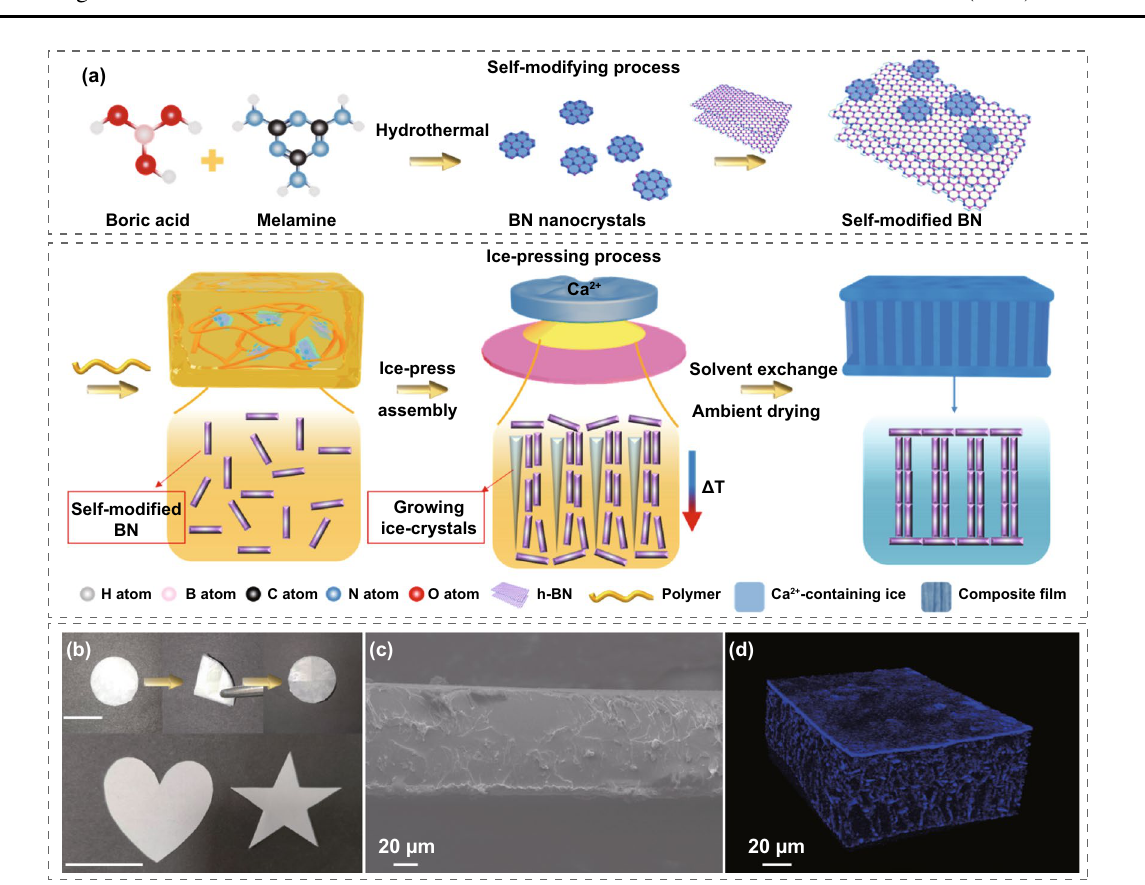
Fig. 1 Fabrication and basic characterization of the polymer/s-BN composite film. a Schematic illustration presenting the fabrication process of the polymer/s-BN composite film. b Photograph, c cross-sectional SEM image and d nano-CT image of the composite film. The scale bar in b is 2 cm. The obtained composite film shows good bendability and ease of